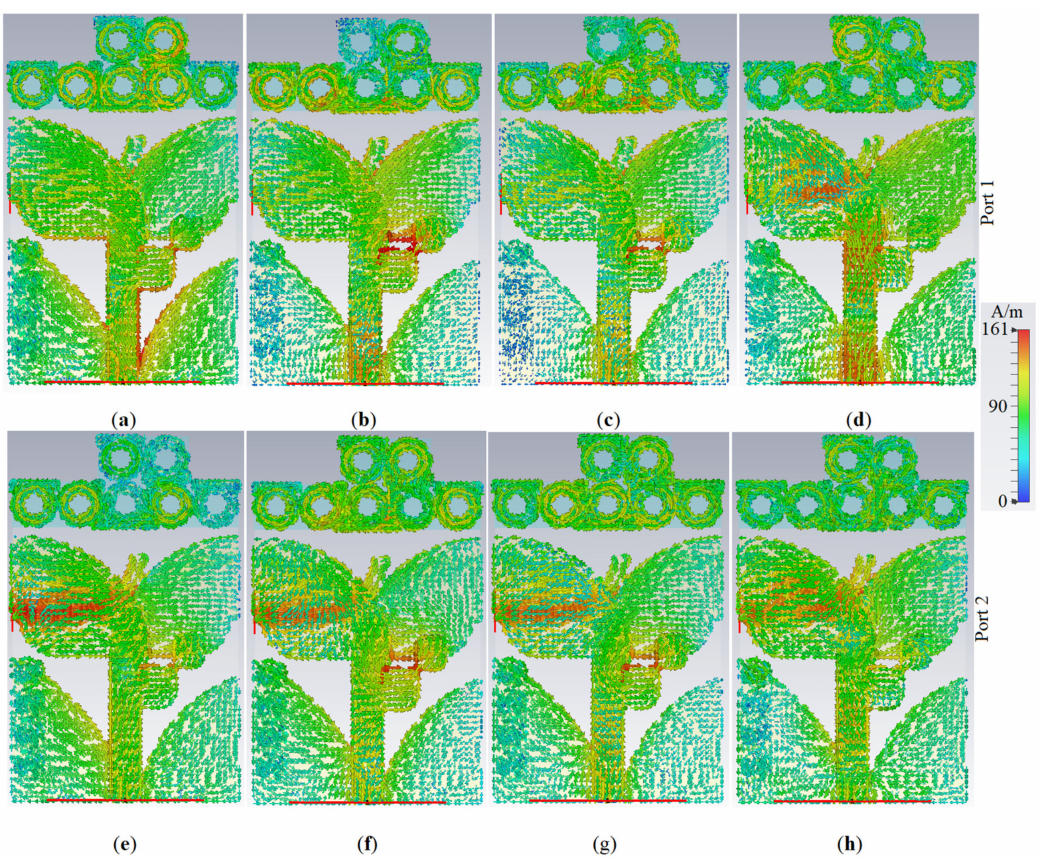
Figure 15. The SCD variation of the proposed antenna: ( a , e ) at 3.8 GHz; ( b , f ) at 5.2 GHz; ( c , g ) at 5.4 GHz; ( d , h ) at 8.0 GHz (red color is maximum and blue is the